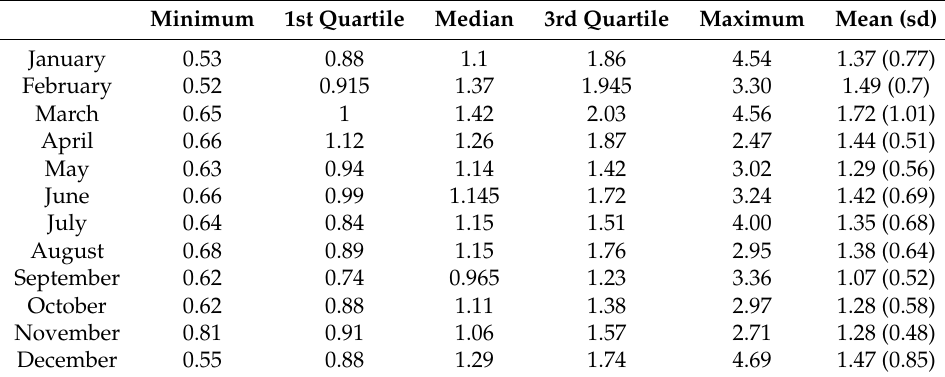
Table 16. Monthly MAPE (in %) for RTE’s based